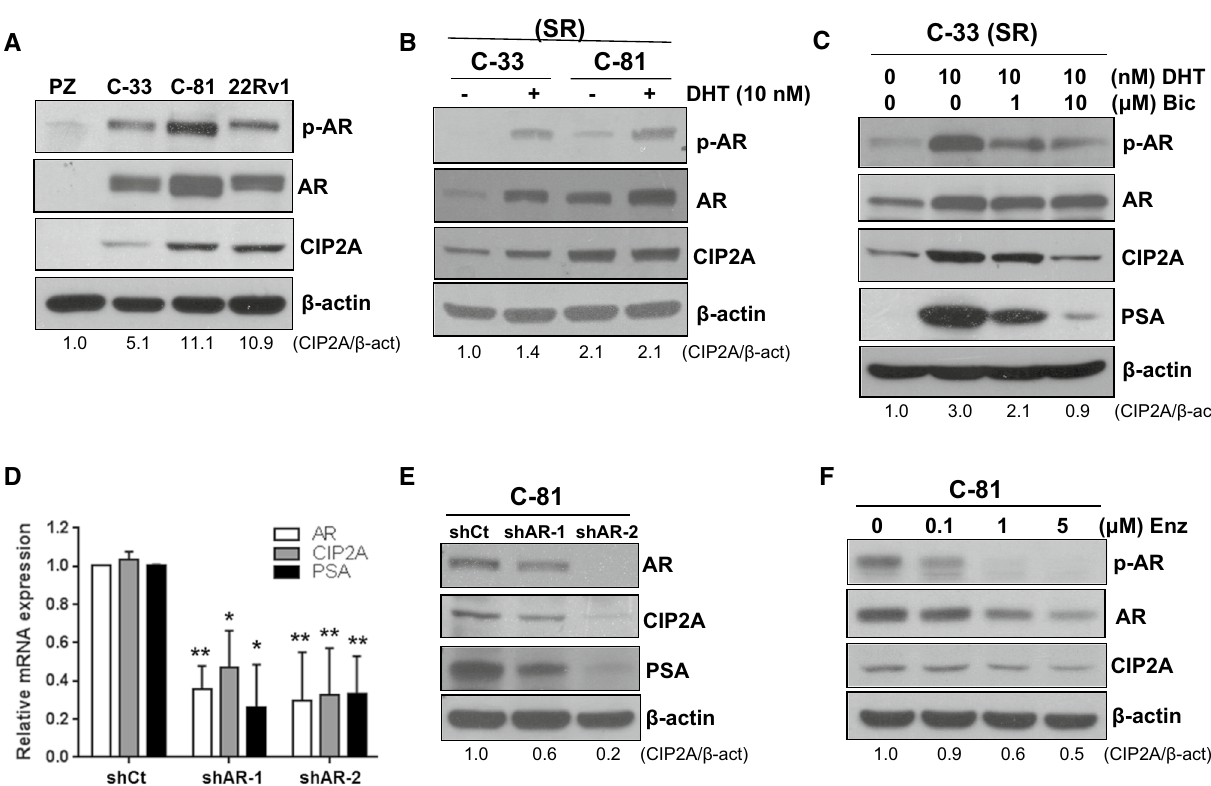
Fig. 2 AR signaling modulated CIP2A protein level in PCa cells. A Total lysates from PZ-HPV-7 (PZ), LNCaP C-33, C-81, and 22Rv1 cells are used for immunoblotting with antibodies against the phosphorylation level of AR at Ser81 (p-AR) and the levels of full-length AR and CIP2A. B LNCaP C-33 or C-81 cells are cultured in a steroid-reduced (SR) medium for 48 h and are then fed with fresh media containing 10 nM dihydrotestosterone (DHT). After additional 48 h of incubation, total lysates are prepared for immunoblotting. C LNCaP C-33 cells are cul- tured in an SR medium for 48 h and are then fed with fresh media containing 10 nM DHT without or with 1 μM or 10 μM bicalutamide (Bic). After 48 h of incubation, total lysates are prepared for immunoblotting. D LNCaP C-33 or E C-81 cells are infected with viruses carrying the LacZ - or AR -targeted shRNA (i.e., shCt, shAR-1, or shAR-2). The cell lysates are prepared for real-time PCR or western blot analyses. Data are expressed as the mean ± SD from three independent experiments. Each set of experiments is conducted in duplicate. *p < 0.05, **p < 0.01 vs. the ratio of the corresponding shCt control cells. F LNCaP C-81 cells are incubated with 0.1 μM, 1 μM, or 5 μM of Enzalutamide (Enz) for 24 h. Subsequently, the total lysates are prepared for immunoblotting. The protein level of CIP2A is quantified using ImageJ software and the relative ratio is normalized to the β-actin